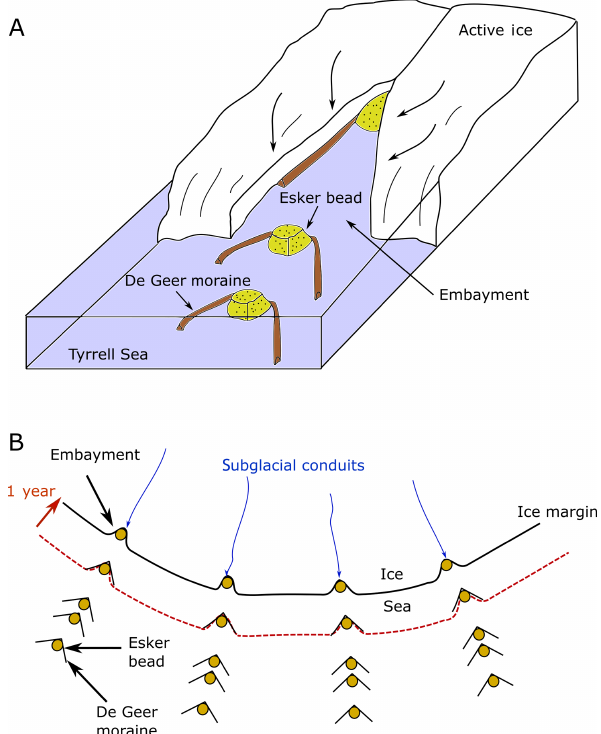
Figure 5. (a) 3-D schematic showing the proposed quasi-annual for- mation of esker beads and De Geer moraines in embayments at a marine grounding line (modified from Warren and Ashley, 1994). De Geer formation likely occurred during subsequent winter ice re- advance and/or deposition of the esker bead prior to the onset or af- ter summer retreat from the moraine. (b) Plan view showing the an- nual deposition of esker beads at the mouth of a series of subglacial conduits. Note how variations in retreat rate affect the downstream spacing of esker beads and that the lateral spacing between individ- ual esker systems is a true measure of subglacial conduit spacing, at least near the inferred palaeo-ice margin.